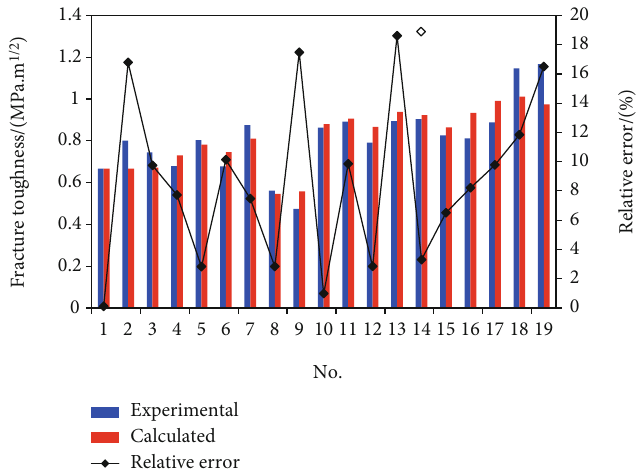
Figure 8: Experimental vs. calculated of fracture toughness of shale samples.